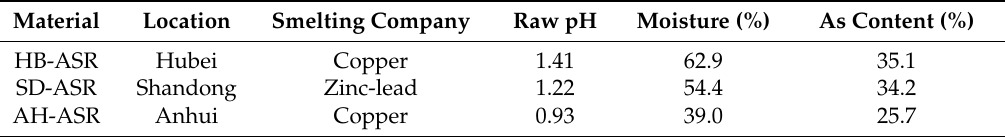
Table 1. The physicochemical properties of the raw